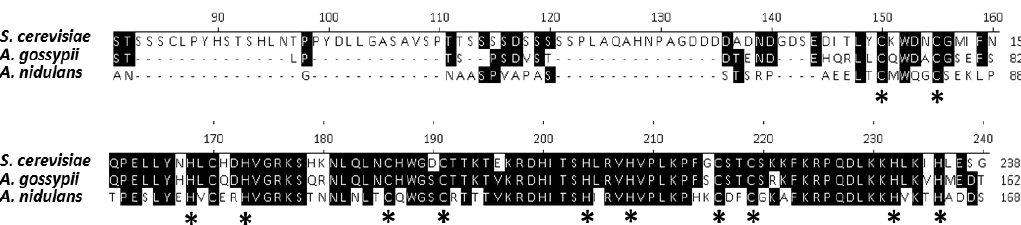
Figure 2. Alignment of the zinc finger regions Rim101/PacC proteins of S. cerevisiae , A. gossypii , and Aspergillus nidulans . The conserved cysteine and histidine residues of the three C2H2 zinc-chelating residues are marked with asterisks [4].